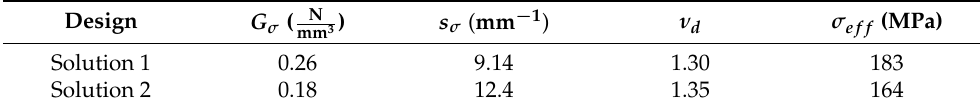
Table 7. Measured and calculated values of axial displacement at different pressure levels.